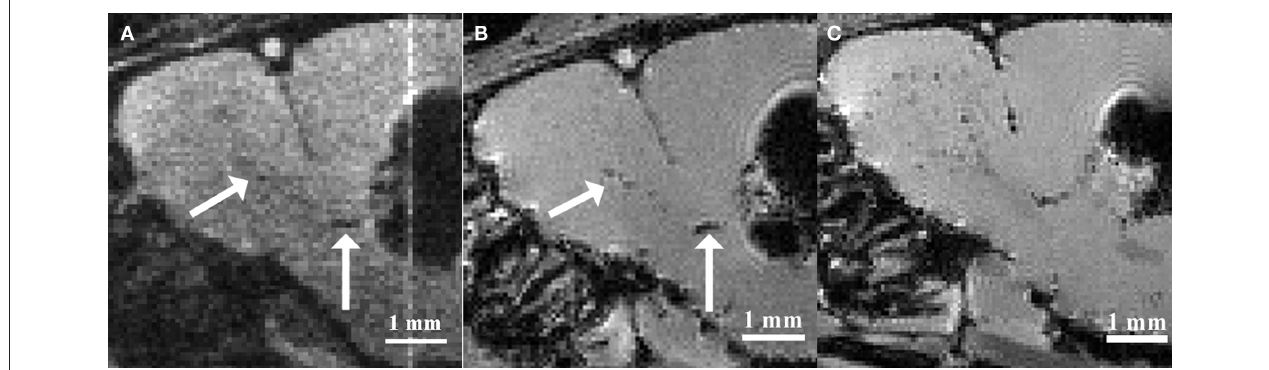
with micron-sized iron oxide particles in the lateral ventricle at 8 weeks post-injection. Arrows indicate corresponding hypointense contrast on the in vivo and ex vivo MRI of the same mouse (Adapted and reproduced from Vreys et al.,